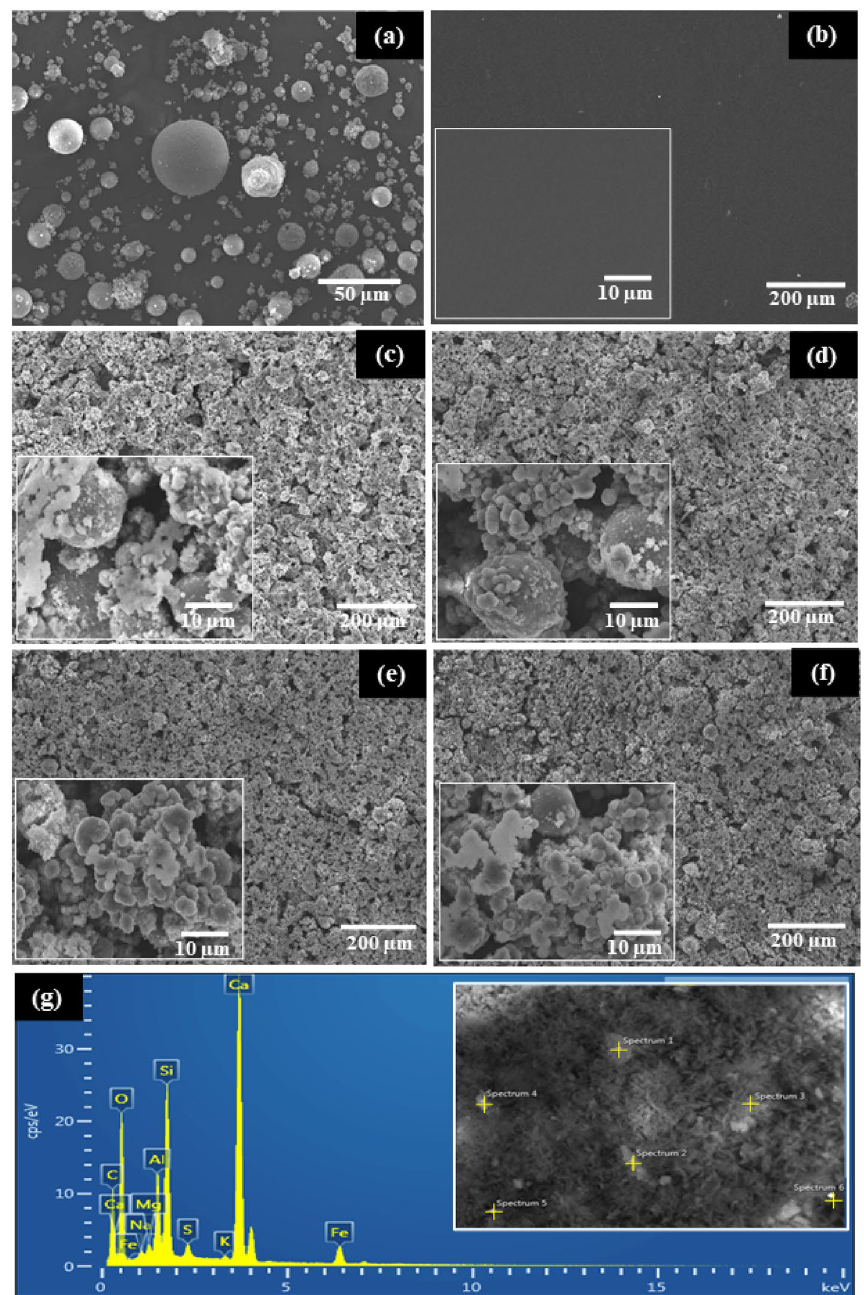
Figure 5. SEM images of fly ash ( a ), PEDOT:PSS film ( b ), and fly ash mixed PEDOT:PSS films (FP) with various concentration ratio of 1:5 ( c ), 2:5 ( d ), 3:5 ( e ), 4:5 g/mL ( f ) and ( g ) an EDX spectrum of fly